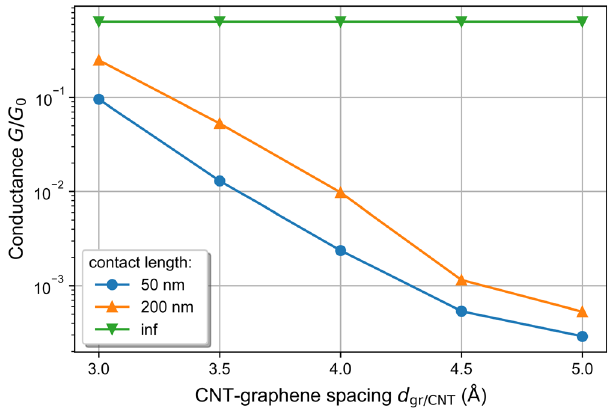
Fig. 5 Scaling of the on-state conductivity with respect to CNT/graphene spacing. The on-state conductivity is plotted against the carbon nanotube/ graphene (CNT/graphene) spacing d gr/CNT on a logarithmic scale. The applied bias is V DS = − 0.5 V and V GS = − 20 V. We observe a strong dependence on d gr/CNT for devices with fi nite contact lengths ( L contact = 50 nm blue and L contact = 200 nm yellow). The on-state conductivity of devices with in fi nite contact length (green) does not depend on the CNT/graphene spacing. We explain this by a saturation of the charge in fl ow from the electrodes. To improve the on-state conductivity, either the contact spacing must be reduced by purifying the CNT from residual polymers, or the contact length has to be increased by depositing longer CNTs. With in fi nite contact length, the conductivity reaches a theoretical limit of 0.6 G 0